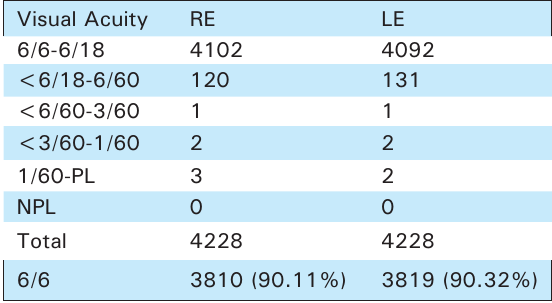
Table 2. Distribution of presenting visual acuity